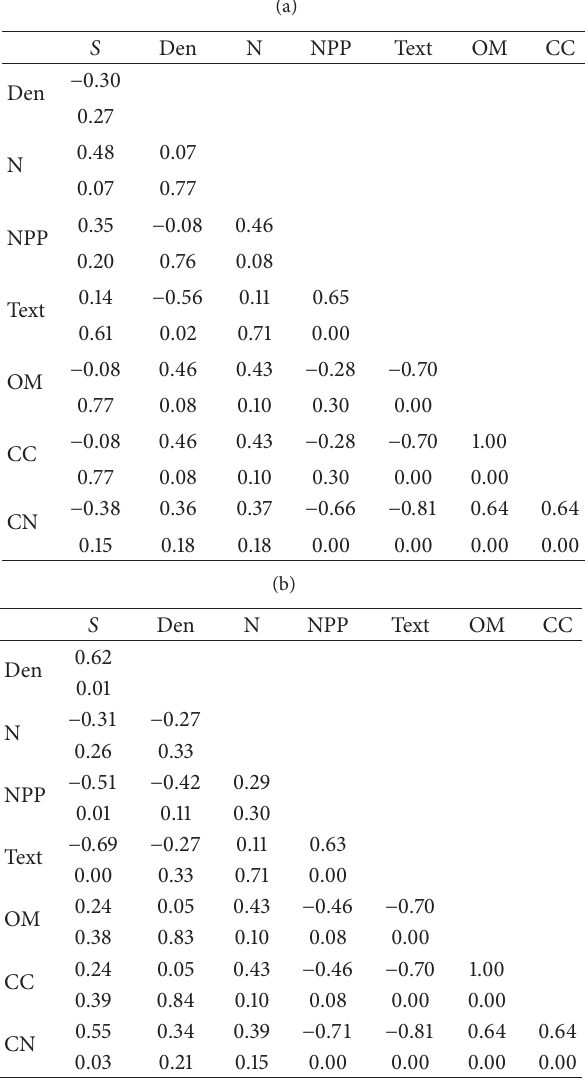
Table 3: Correlation matrices for early and late successional stages between productivity, diversity, and environmental variables in Tamaulipan thorn scrub forests of northeastern